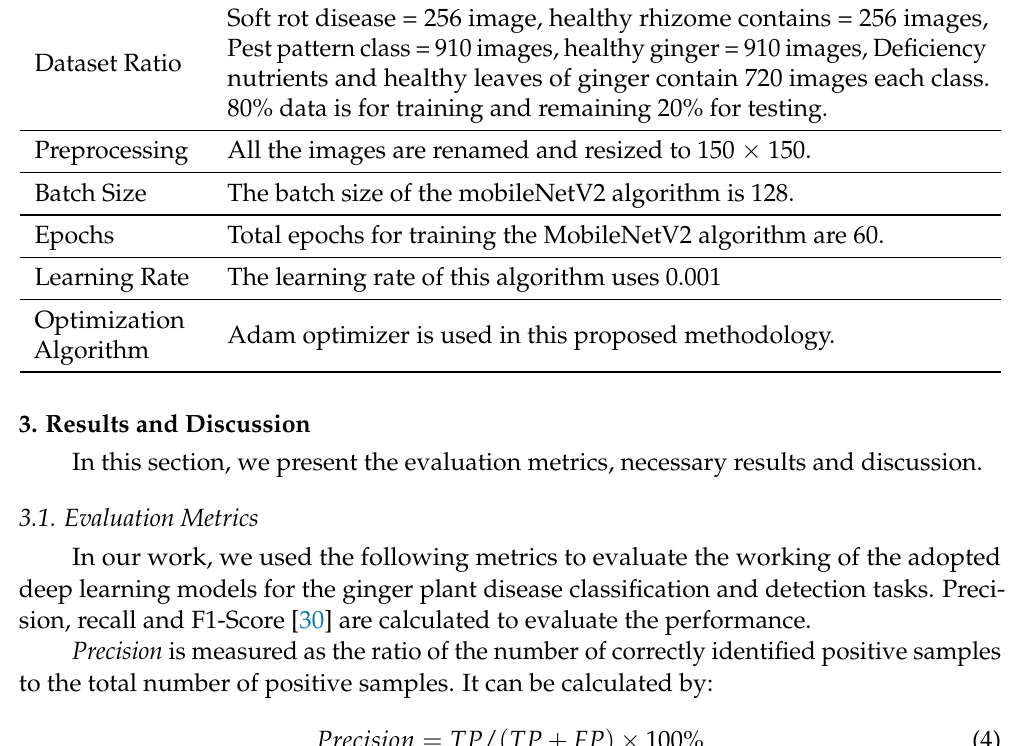
Table 7. Hyper parameters tuning used for MobileNetV2.